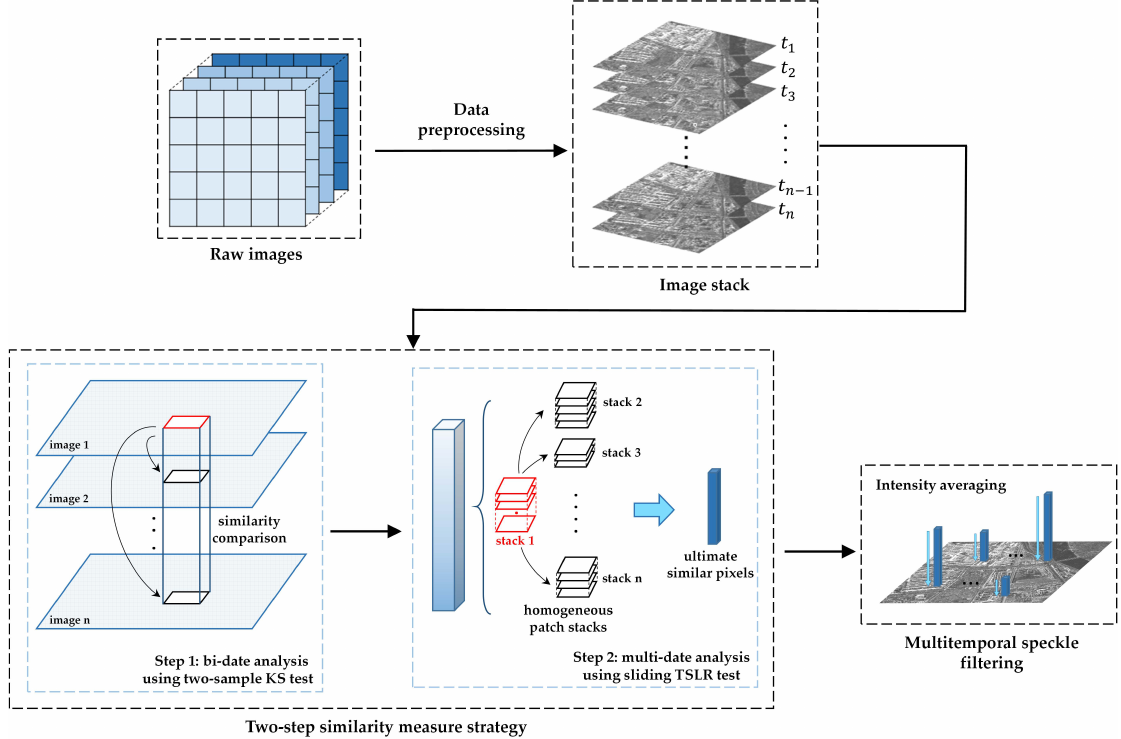
Figure 1. The processing flow of the proposed filtering